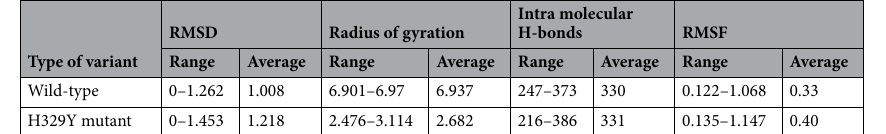
Table 2. Analysis of MD trajectory of the wild-type of GATA6 and the H329Y